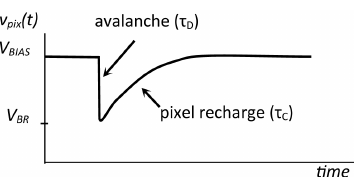
Figure 2. Waveform of the pixel voltage v pix ( t ) for a single avalanche